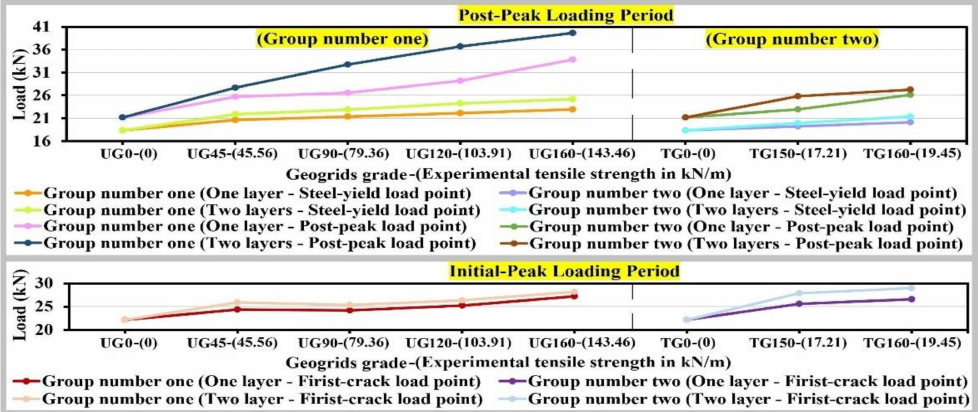
Figure 13. The e ff ect of geogrids type, the tensile strength of geogrids, and the number of geogrids’ layers on concrete slabs’